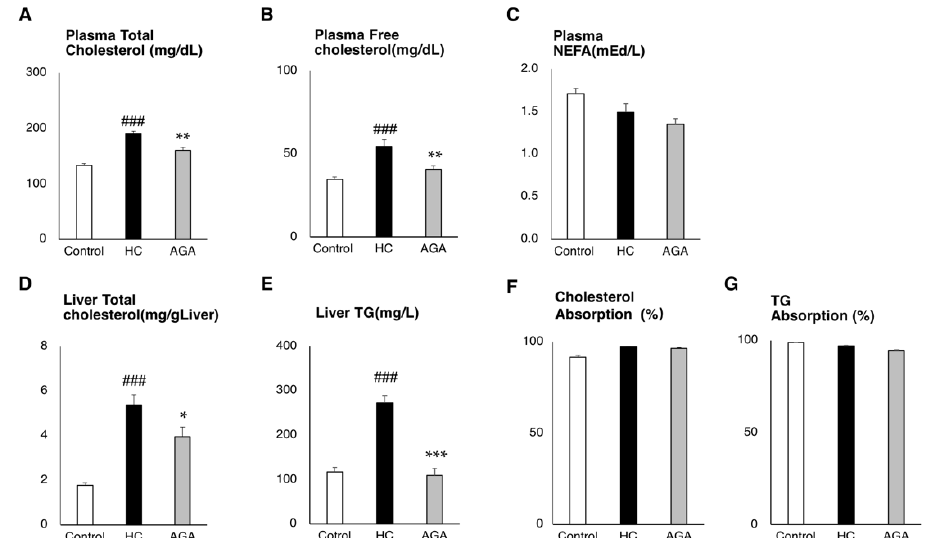
Figure 2. Agaricus brasiliensis KA21 (AGA) prevents lipid accumulation. Control diet (Control), high-fat and high-cholesterol diet (HC), and high-fat and high-cholesterol + 5% AGA. ( A ) Plasma lipid parameters for total cholesterol; ( B ) plasma lipid parameters for free cholesterol; ( C ) plasma lipid parameters for non-esterified fatty acid; ( D ) liver lipid parameters for total cholesterol; ( E ) liver lipid parameters for triglyceride (TG); (F ) percentage of cholesterol absorption; ( G ) percentage of triglyceride (TG) absorption. Data are presented as the mean ± SEM values. n = 7 mice per group. Statistical analysis was performed by one-way ANOVA, followed by Bonferroni’s post-hoc test. * p < 0.05; ** p < 0.01, ### / *** p < 0.001 versus mice in the HC group ( # significant di ff erences for HC versus Control, * significant differences for HC versus AGA).